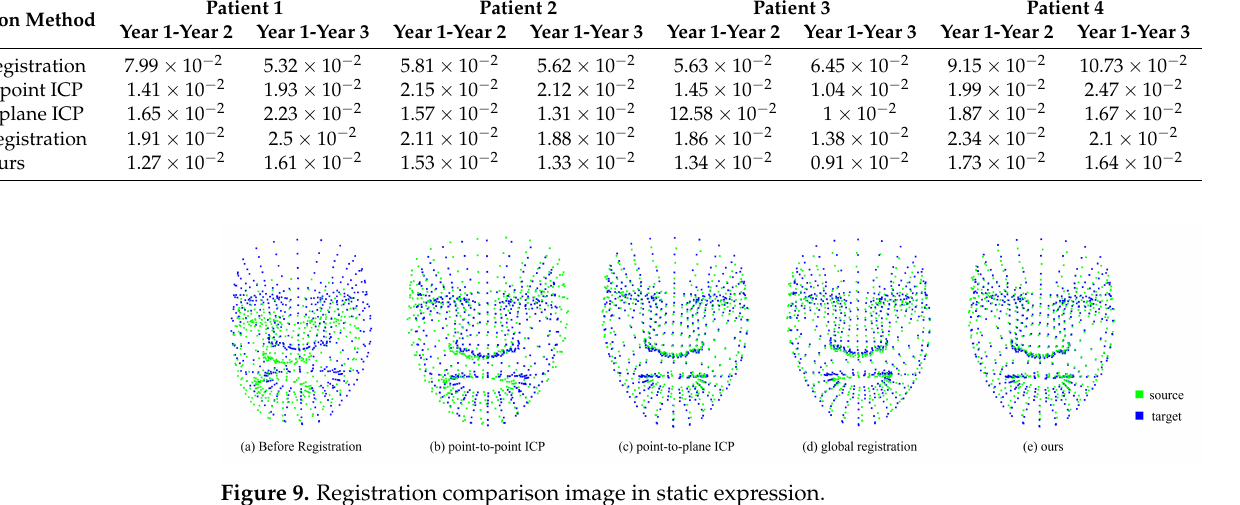
Figure 9. Registration comparison image in static expression.